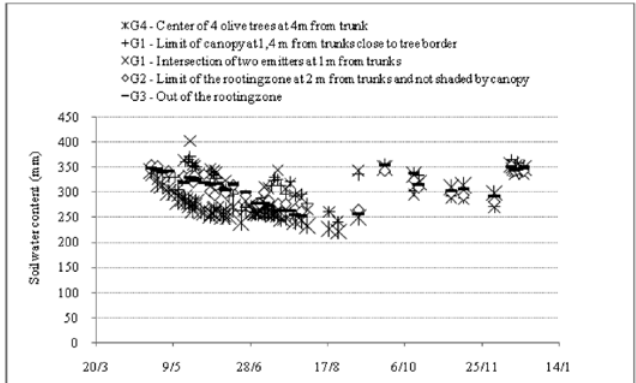
Fig. 6 - Soil water stocks (mm) determined for all the profile (0-100 cm depth) at 1.4 m (G from trunks.